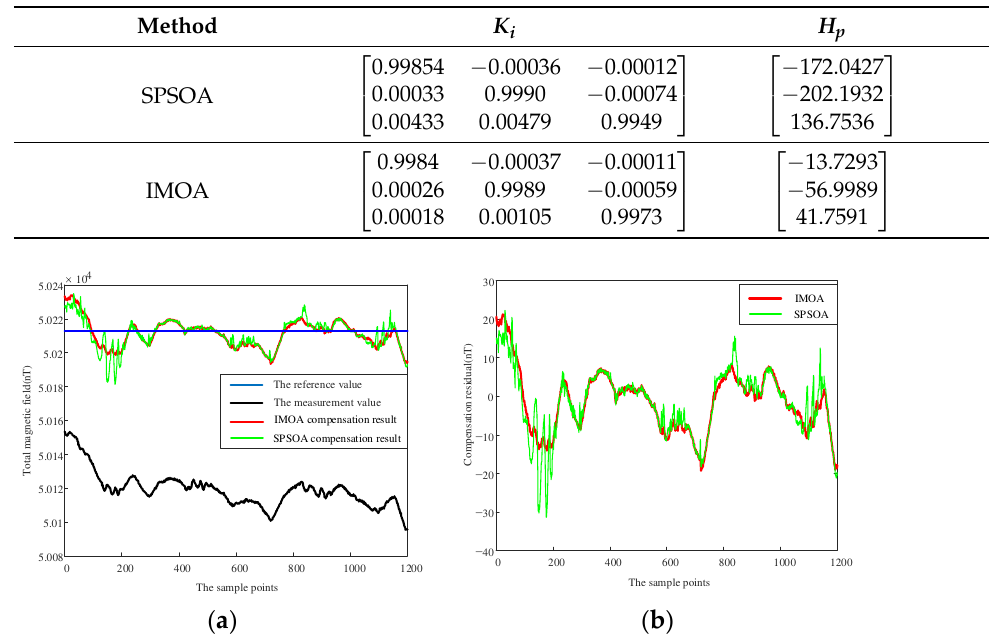
Table 3. Compensation parameters values estimated using the two methods.